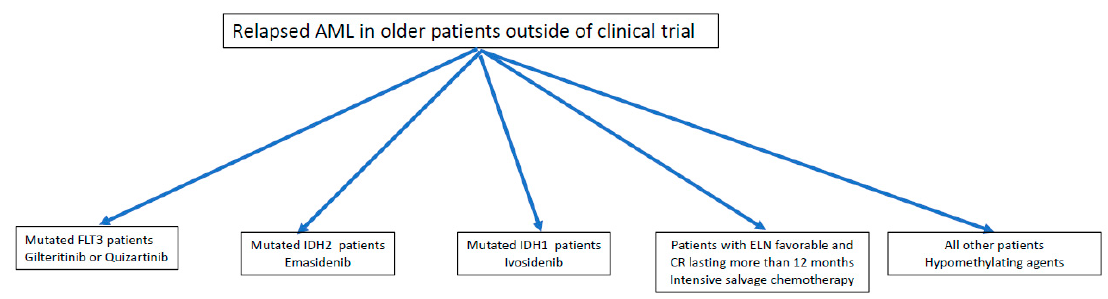
Figure 4. Potential therapeutic algorithm for older patients with relapsed AML elderly. ELN: European